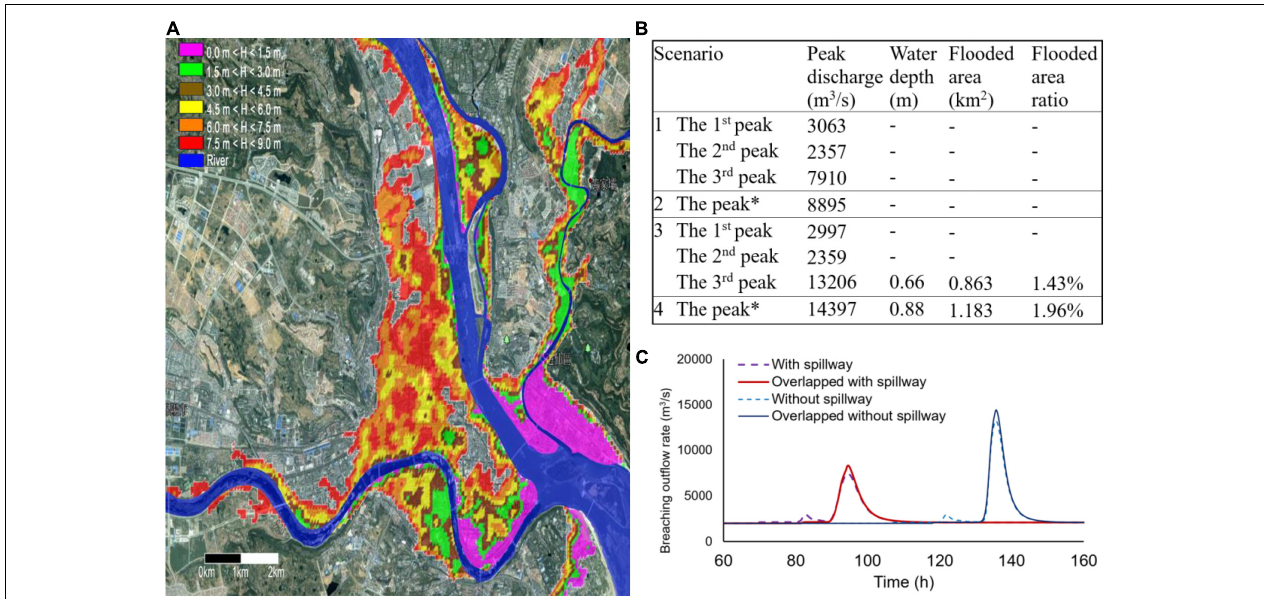
FIGURE 8 | The hydraulic parameters of different scenarios in Mianyang City: (A) the flood inundation map with different water depth ranges; (B) the peak discharge and the maximal water depth; and (C) the discharge curves along time.